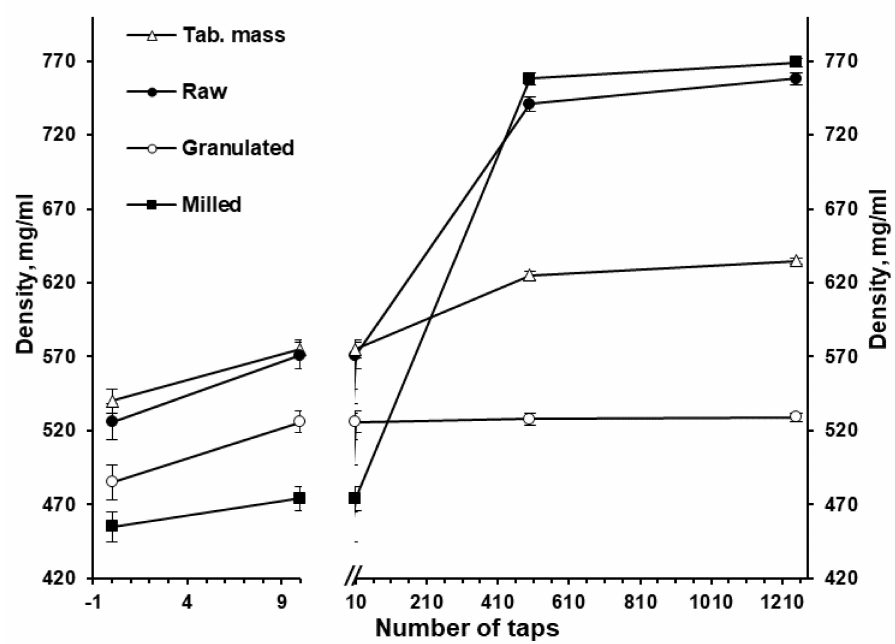
Figure 4. The effect of tapping on the apparent density of raw, milled, and granulated isoniazid as well as mixture for tableting ( n = 3).